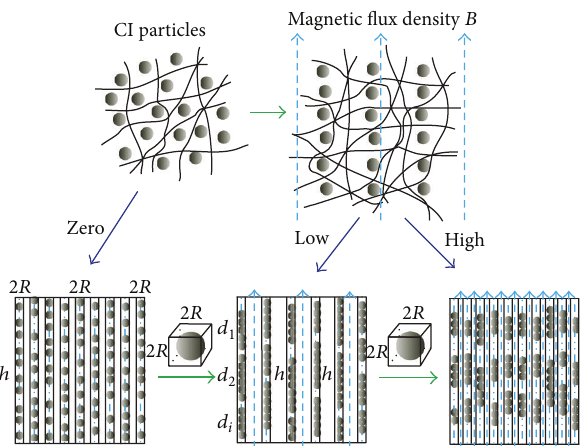
Figure 10: Schematic diagram of chain-formation mechanism for MRSPs under magnetic field and the nonperforative particle aggregated chains